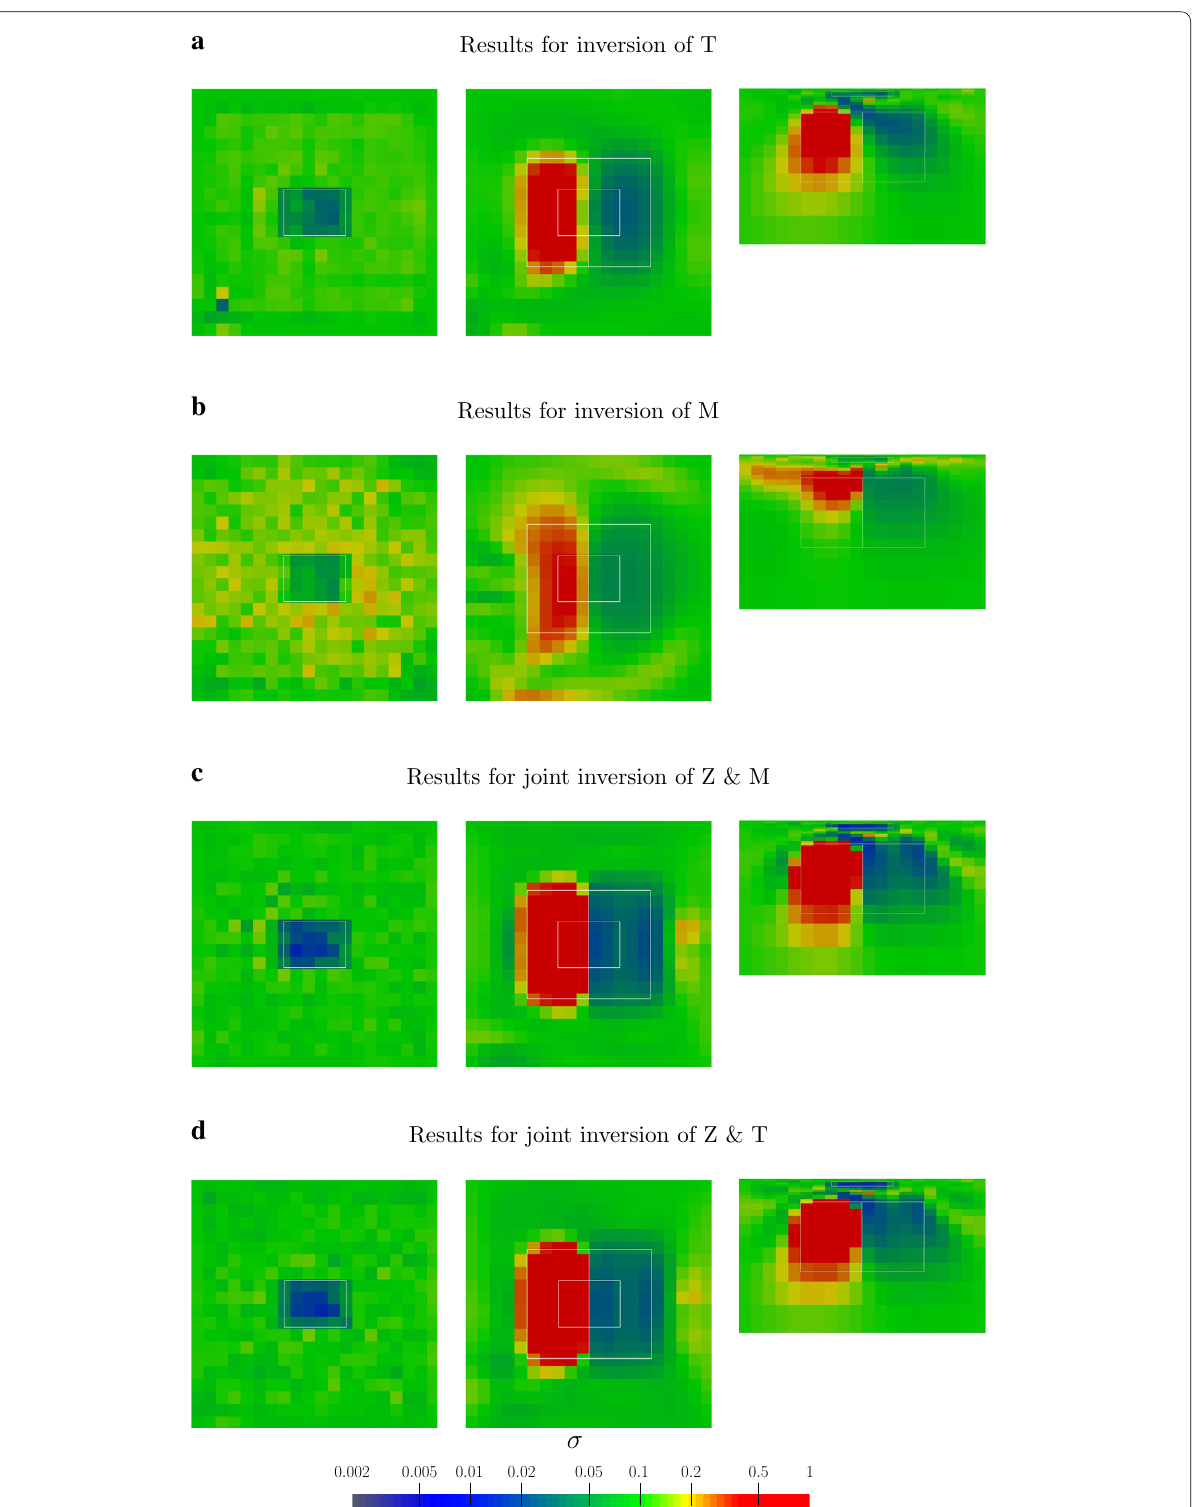
Fig. 5 Models recovered by inversion of horizontal telluric tensor T ( a ), horizontal magnetic tensor M ( b ), by joint inversion of Z and M ( c ), and by joint inversion of Z and T ( d ). The results are shown through the same cross sections upper plots of Fig. 1, for the case when reference site was placed in 1-D